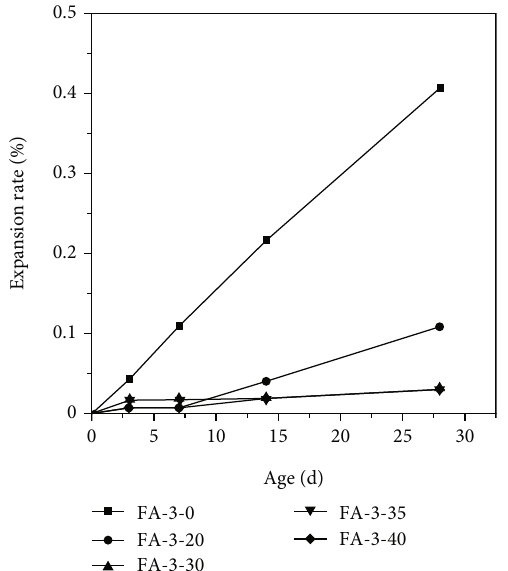
Figure 11: Graph of the expansion rate of the specimen and the amount of coal ash content (cement alkali content 1.25%).